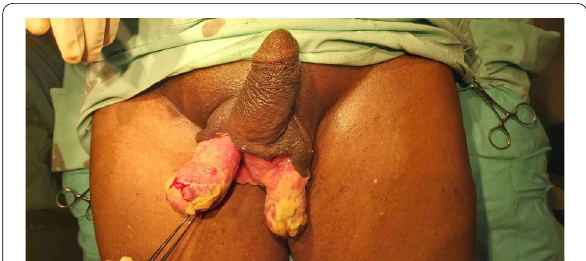
Fig. 1 The scrotal defect with exposed testicles at reconstruction